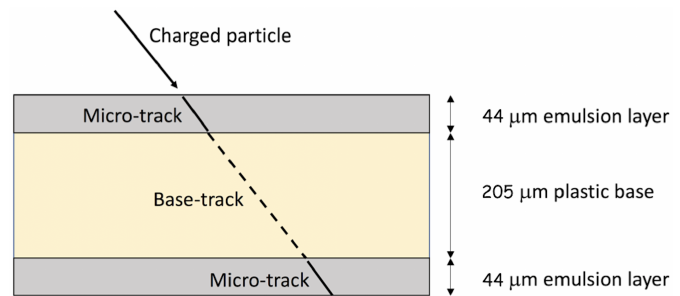
Figure 3. Schematic view of an emulsion film with two micro-tracks: In yellow, the triacetate base and, in grey, the two sensitive emulsion